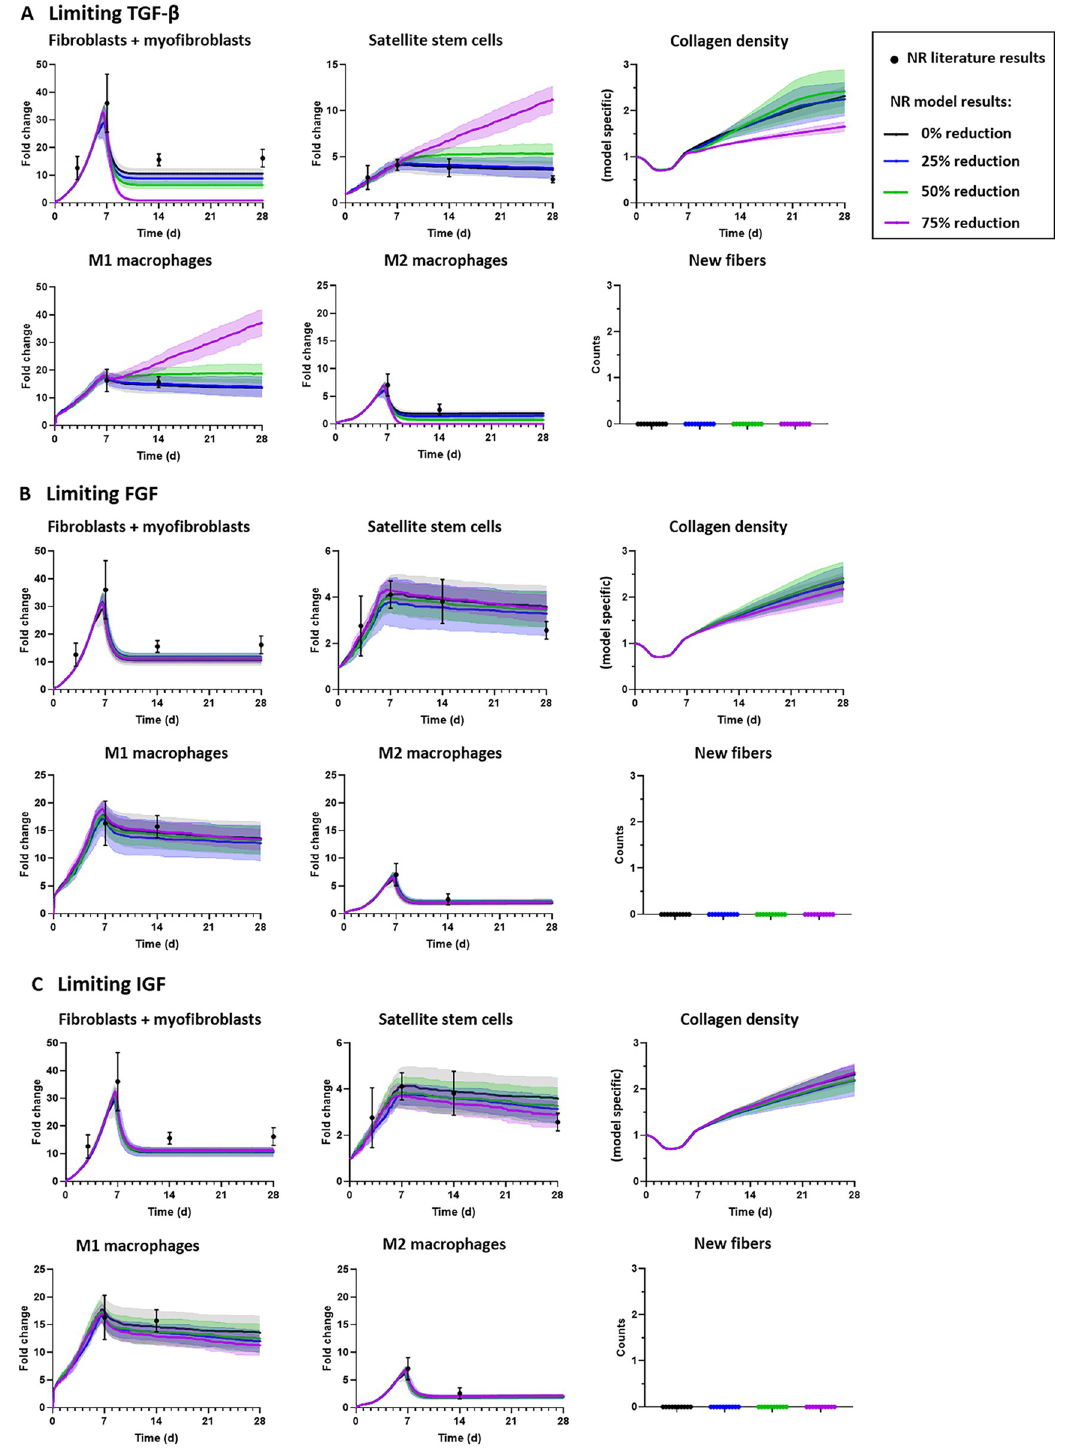
Fig 8. Limiting the amount of growth factors produced by fibroblasts in the no repair (NR) ABM revealed that only a large reduction in TGF- β levels altered the collagen density following VML injury. The levels of TGF- β (A), FGF (B), and IGF (C) were reduced to 25%, 50% and 75% below baseline levels, and fibroblast, SSC, and macrophage fold changes, collagen density, and counts of new, regenerated fibers were predicted. A 75% reduction of TGF- β secretion by fibroblasts increased the number of SSCs present and decreased the rate and amount of collagen accumulation (A). None of the perturbations resulted in new fibers